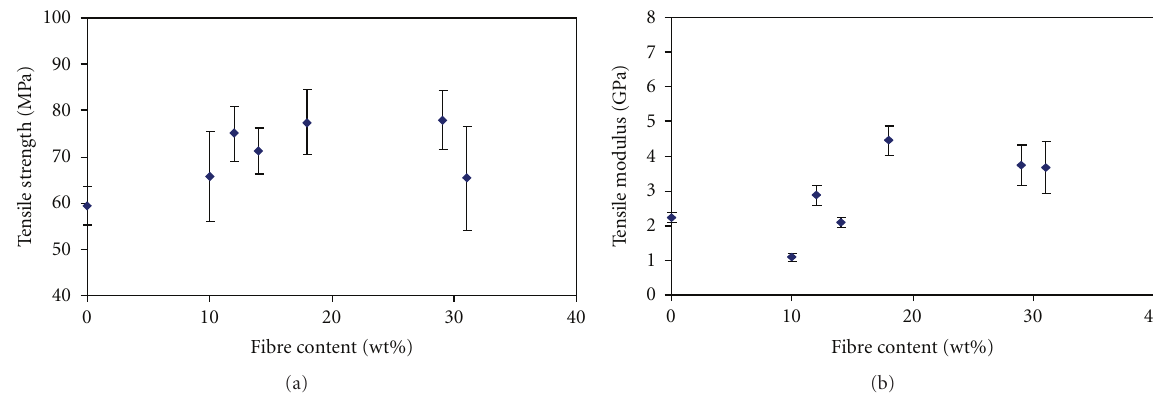
Figure 7: (a) Tensile strength of composites, (b) tensile modulus of